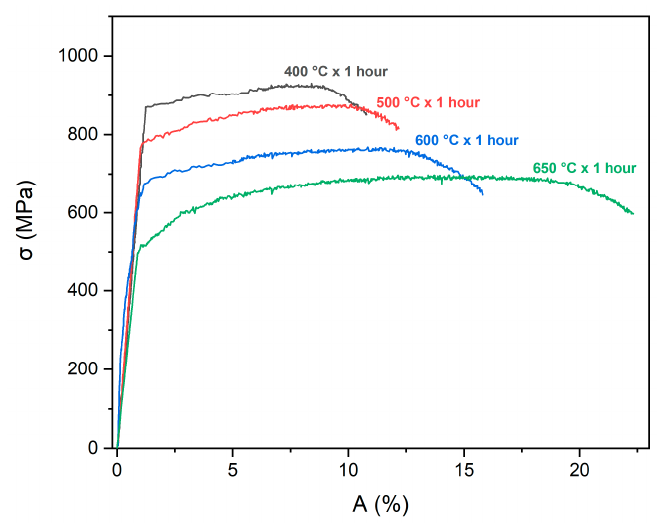
Figure 13. Tensile test curves of EUROFER97 steel cold rolled with CR of 80% and heat-treated at 400 °C, 500 °C, 600 °C and 650 °C for 1 h.